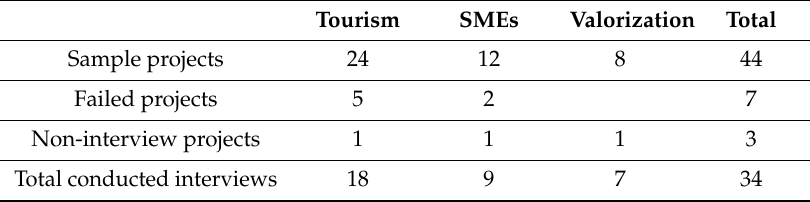
Table 2. Number of projects in the sample and interviews